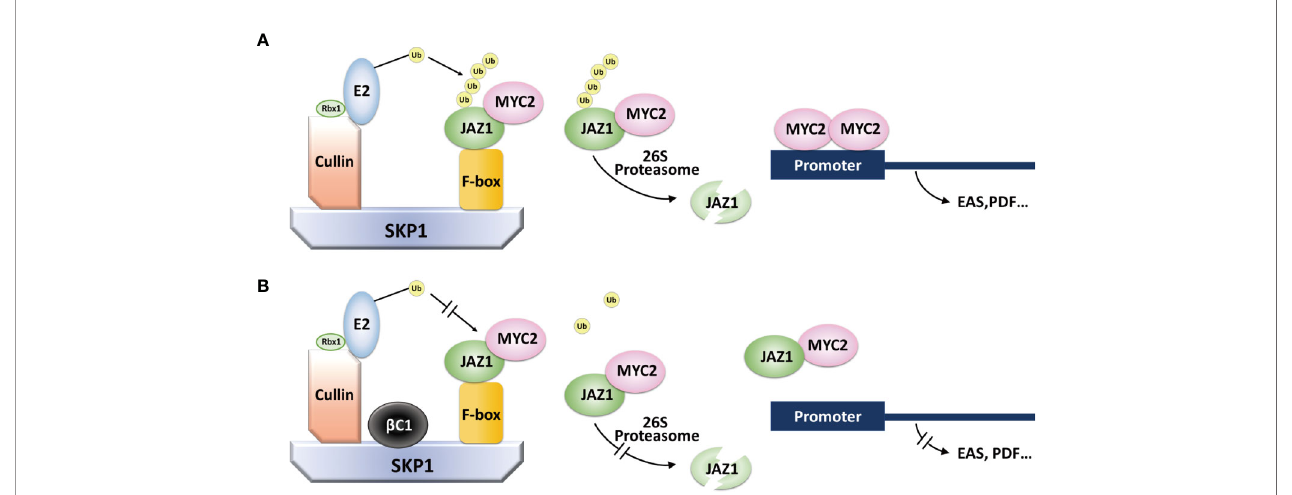
FIGURE 6 | A model for the role of b C1 in regulating plant defense reaction. (A) The signaling pathway of SCF complex in plants. SCF complex is one kind of E3 ligase. E2-Ub complex can interact with E3 ligase via the help from Rbx1, making the E3 protein substrates (JAZ1) carry with polyubiquitin chain. Then, JAZ1-Ub chain is recognized by 26S proteasome, eventually degraded, releasing MYC2 transcription factor to activate genes expression in plant defense. (B) The pathway of SCF complex when plants were infected by TYLCCNV. b C1 can bind to SKP1 protein and interfere the normal function of SCF complex. JAZ1-MYC2 was stable and genes expression in plant defense were not